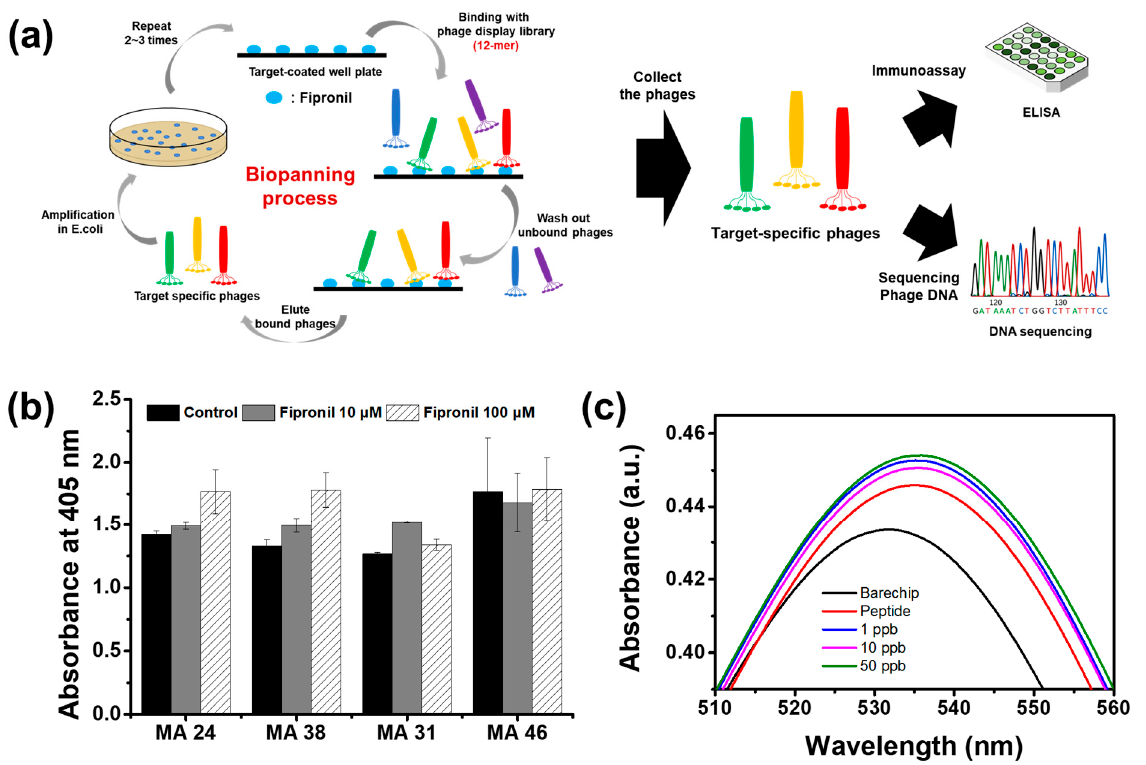
Figure 1. Screening of specific binding peptides of fipronil through phage display technique: ( a ) biopanning process and identification of fipronil-specific peptides, ( b ) screening of phage candidate group displaying peptides specific for fipronil, and ( c ) detection of fipronil using optimized LSPR sensor